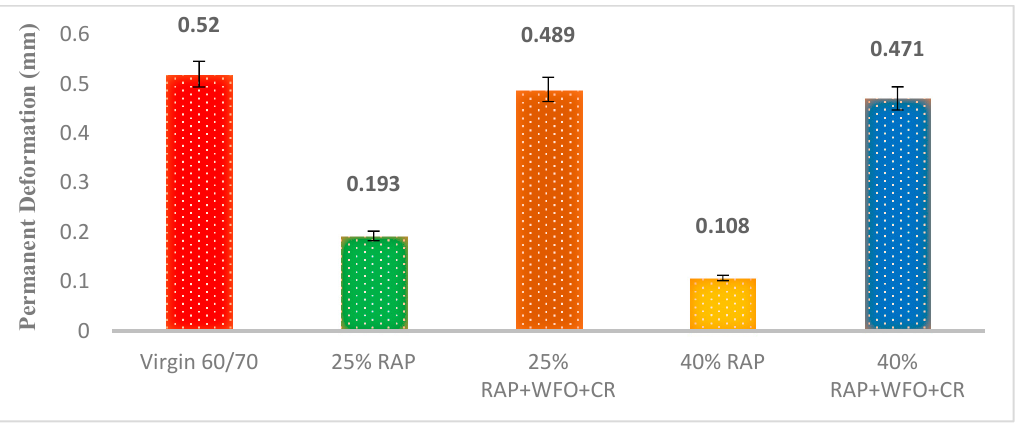
Figure 5. The permanent deformation of all samples at 40 °C. Table 18. The significant difference in the group means for the dynamic creep of the virgin asphalt with RAP and the recycled asphalt mixtures at 40 °C.